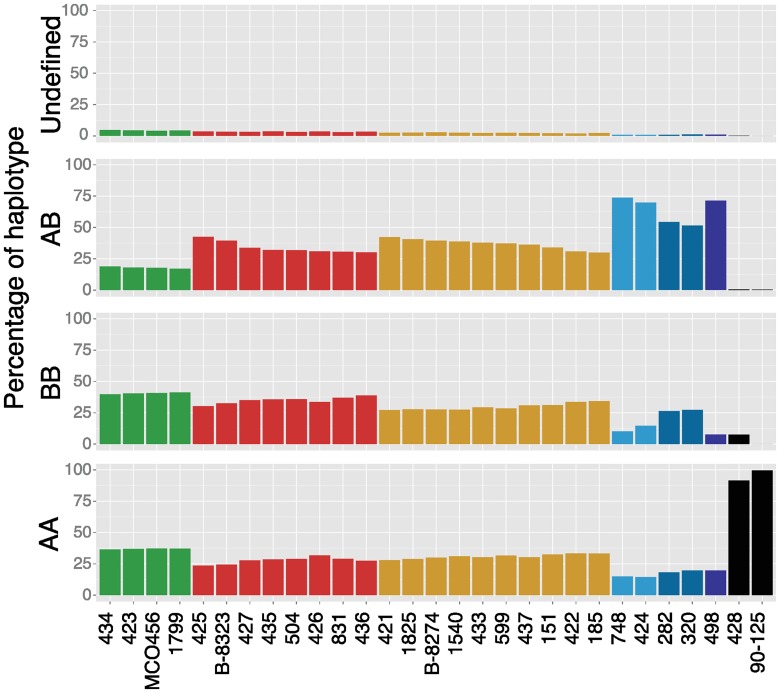
There is no bias towards haplotype A or haplotype B during LOH events in heterozygous isolates.The percentages of 1 kb regions of each isolate categorized as homozygous haplotype A (AA), homozygous haplotype B (BB), heterozygous (AB) and undefined are shown. Isolates are ordered according to their clade (Fig 2; Clade 1 green, Clade 2 red, Clade 3 orange, Clade 4.1 light blue, Clade 4.2 blue and Clade 4.3 dark blue) and by the amount of heterozygosity within each clade.